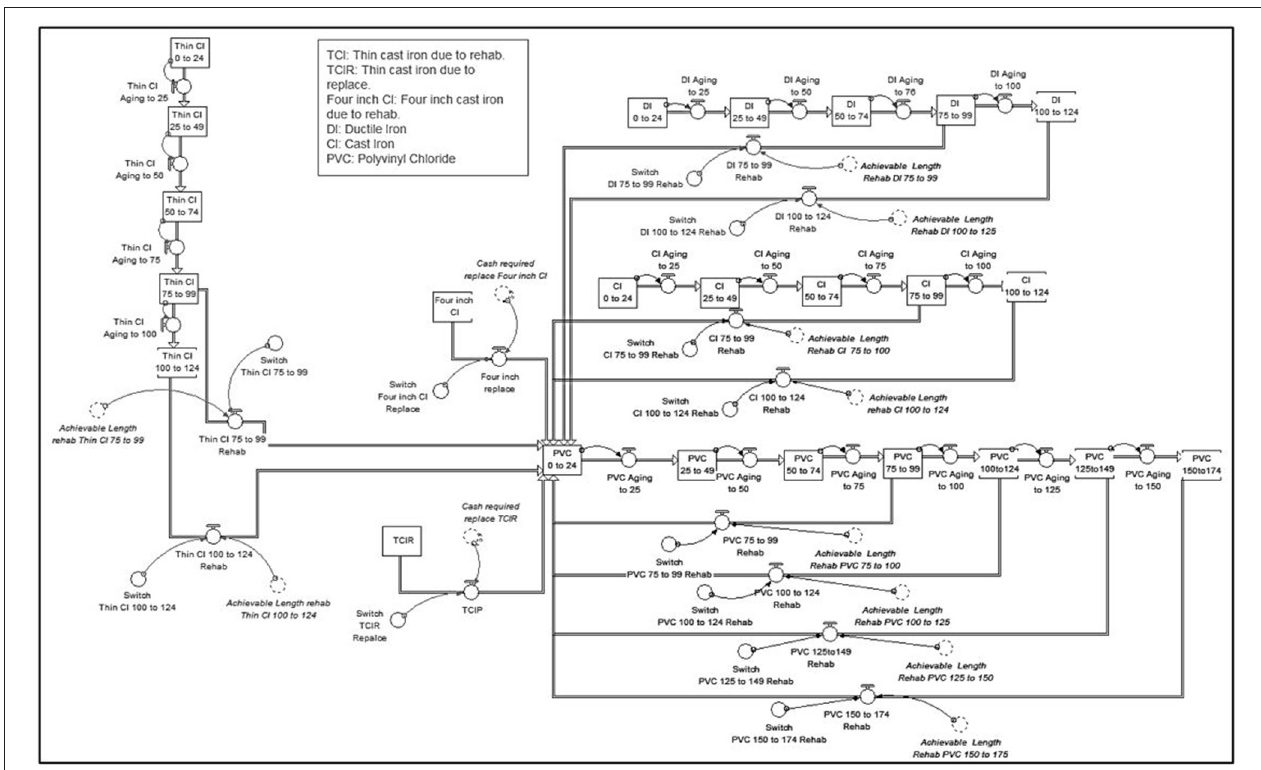
FIGURE 3 | Infrastructure sector of the advanced system dynamic model in Stella ®